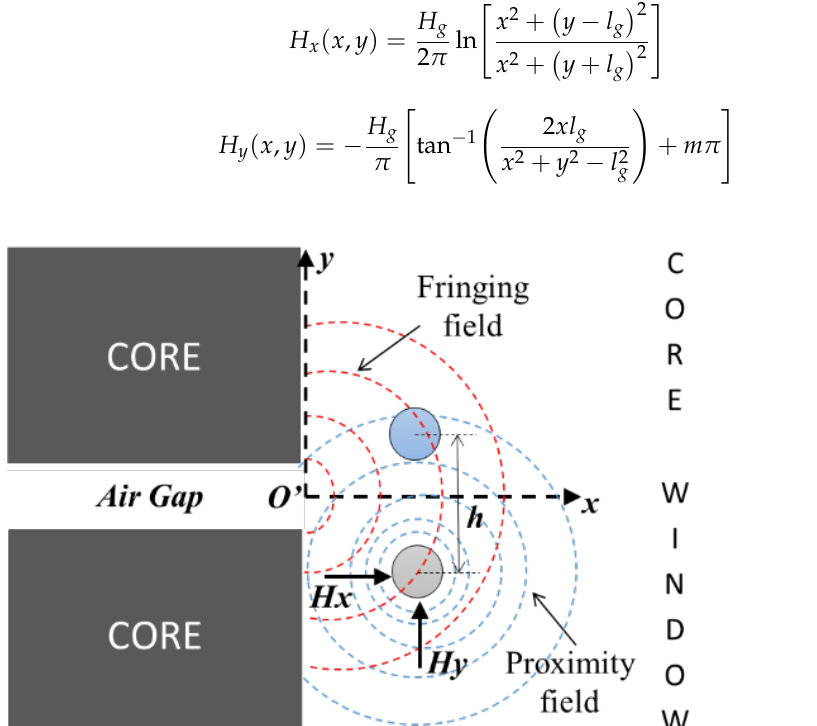
Figure 2. Representation of fringing and proximity ideal fields over a round conductor in a gapped magnetic component.